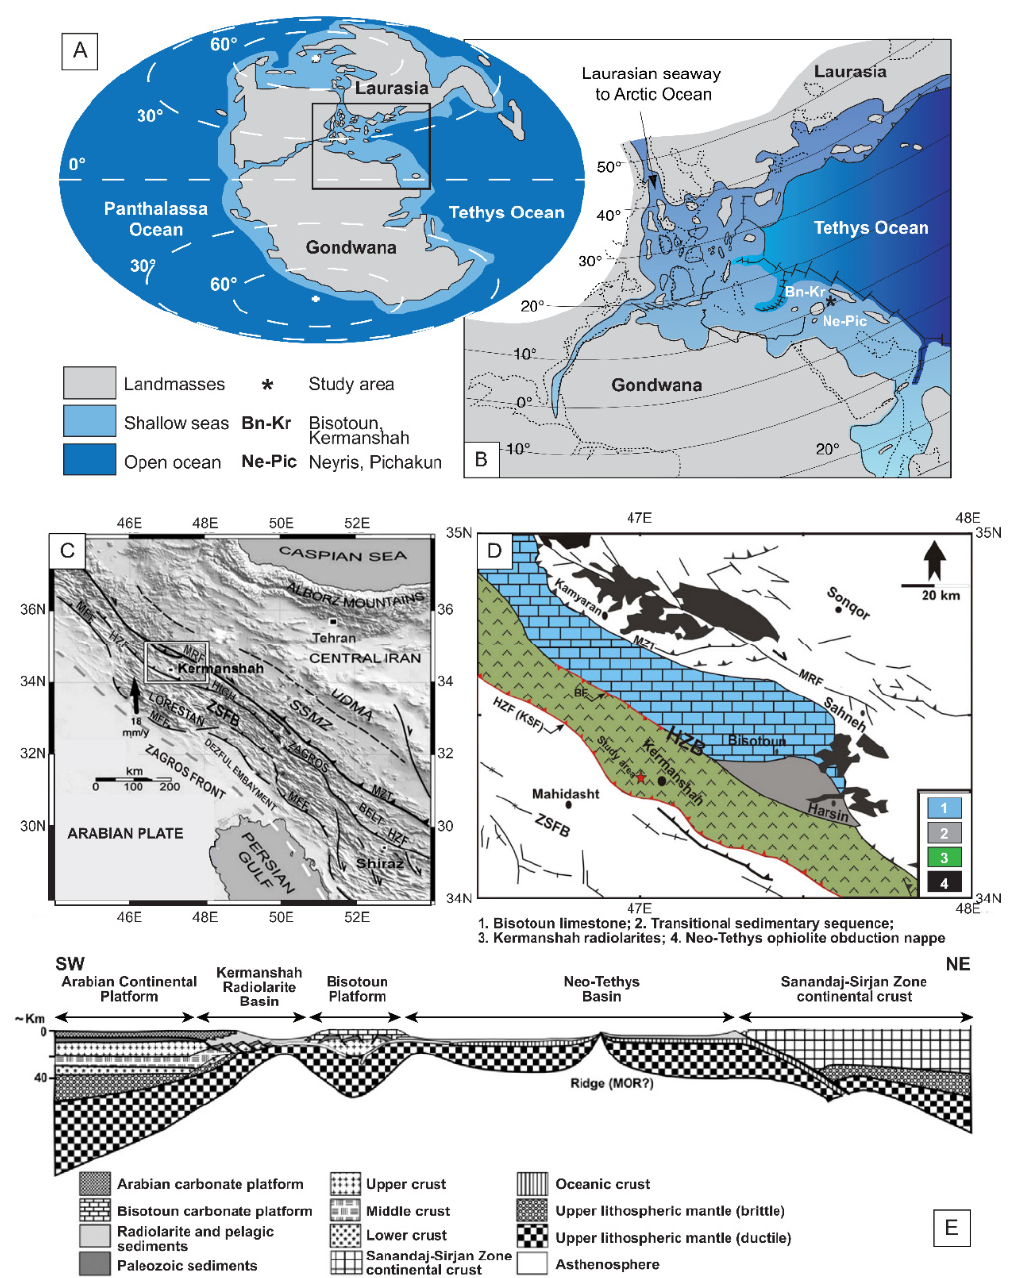
Figure 1. ( A ) Paleogeographic map of Lower Jurassic (modified after Blakey [28]. ( B ) Paleogeography of the western Tethys with location of the studied Kermanshah Radiolarite Basin (modified after Bassoulet et al. [15]). ( C ) Regional map of the Zagros fold-and-thrust belt, indicating the location of the studied area of Kermanshah in west Iran (see rectangle). Topography comes from http://edc.usgs.gov (accessed on 18 December 2021). ( D ) Simplified geological map indicating the main tectonostratigraphic domains and showing the position of the studied section near Kermanshah (red star) in the High Zagros Belt (HZB). The Kermanshah radiolarite outcrops are limited by the Bisotoun Fault (BF) to the north and the Kuh-e-Sefid Fault (KSF = HZF) to the south (after Abdi et al. [1], and Navabpour et al. [18], modified). ( E ) Sketch showing a cross-section from the Arabian continental platform to the Sanandaj–Sirjan active margin for the Early Jurassic, with the location of the Kermanshah Radiolarite Basin. The latter was separated from the Neo-Tethys Basin by the Bisotoun carbonate platform (modified from Wrobel-Daveau et al. [22]).